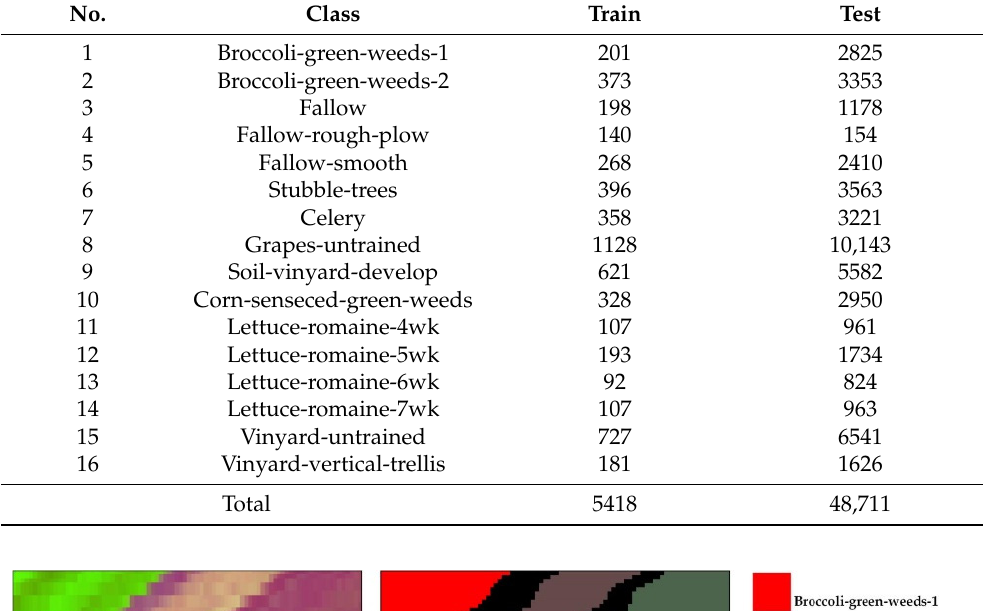
Table 4. Land cover class information for the SA dataset.